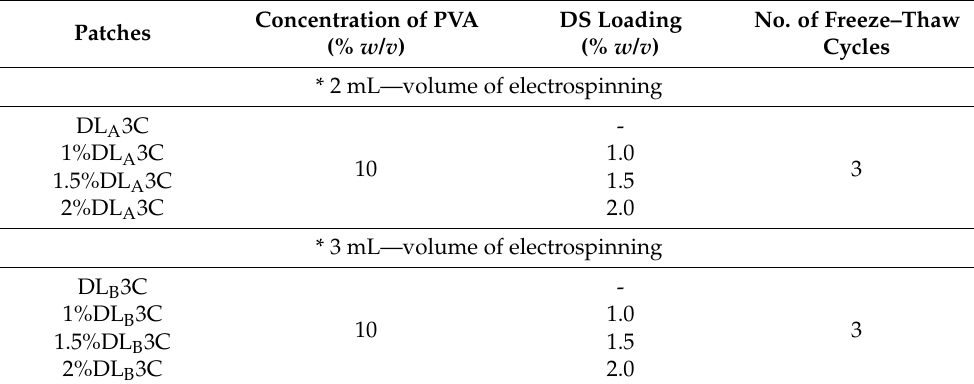
Formulations of unmedicated and diclofenac sodium (DS)-medicated dual layer PVA patches. Concentration of PVA Patches (% w/v )